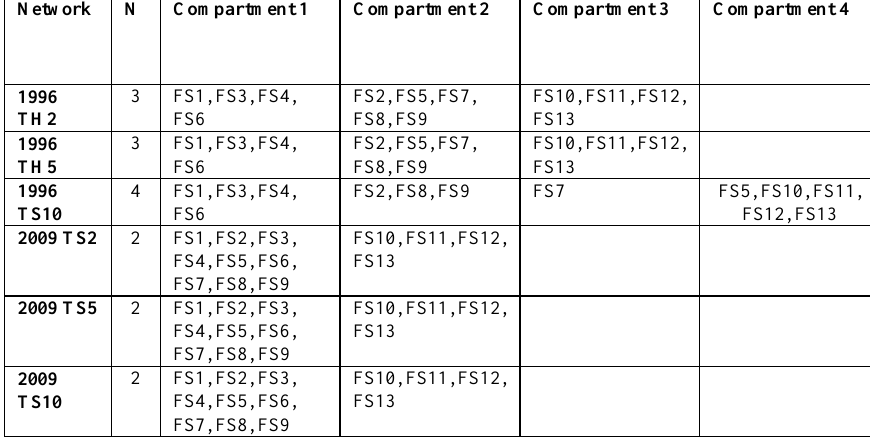
Table A4. Compartmentalization sensitivity analysis for link thresholds (TH) 2%, 5% and 10% in compartmentalization analysis.